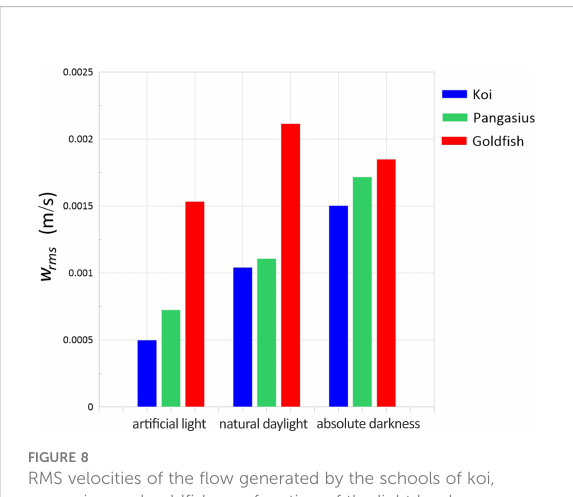
FIGURE 8 RMS velocities of the fl ow generated by the schools of koi, pangasius, and gold fi sh as a function of the light